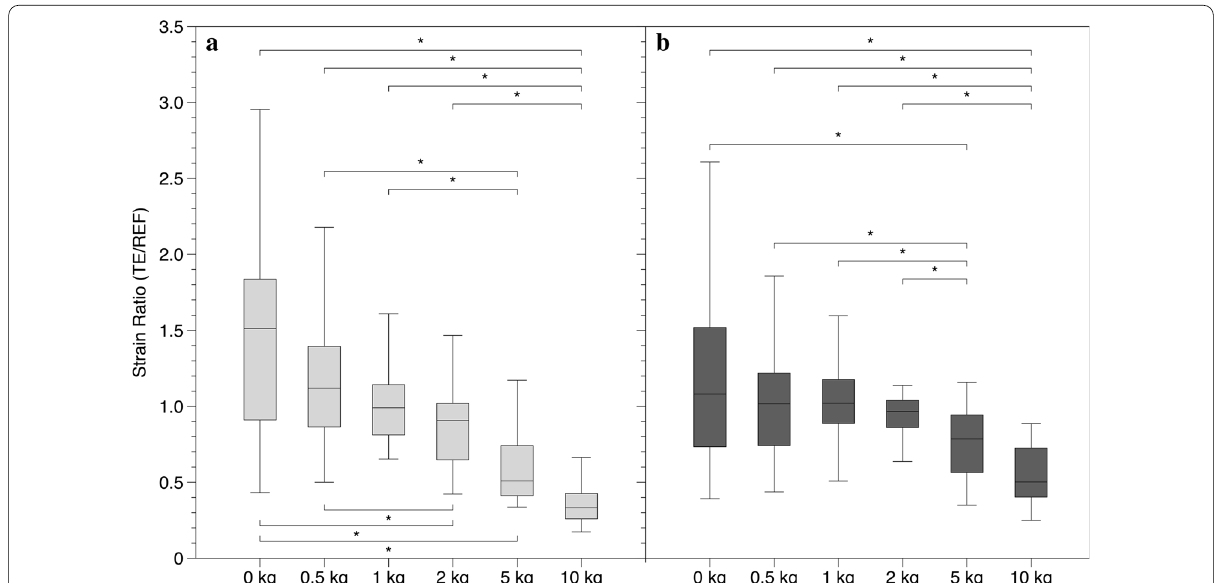
Fig. 3 Strain sonoelastography. Box plot showing the median and IQR strain ratio (TE/REF) values of the entire sample for the different contraction levels a SE1 and b SE2. * p < 0.05; statistical significant difference between the different contraction